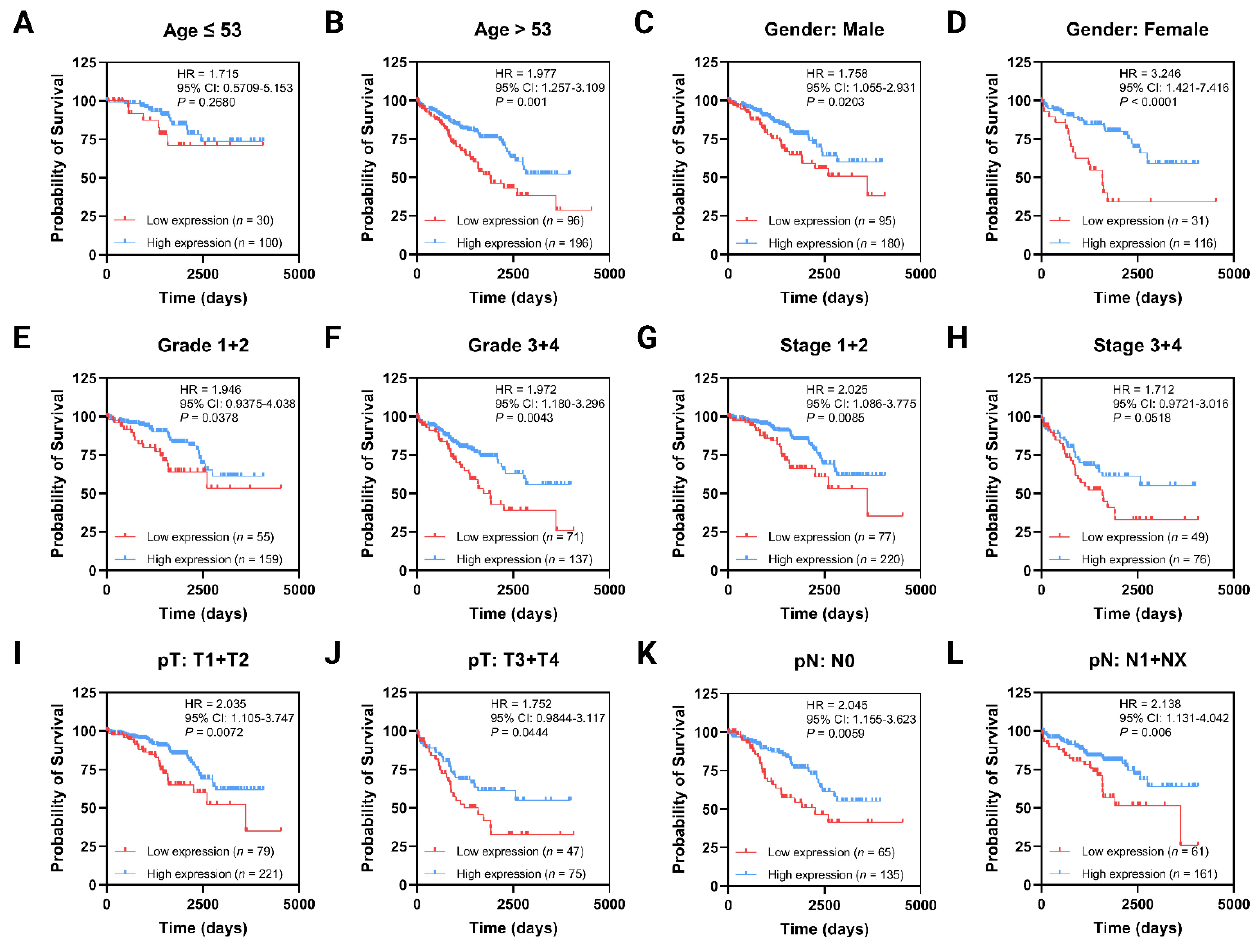
Figure 2. Kaplan – Meier curves demonstrating the impact of ANO4 expression on the OS within subgroups of dichotomized demographics and clinicopathological variables including age ( A , B ), gender ( C , D ), grade ( E , F ), stage ( G , H ), pT ( I , J ), and pN ( K , L ).